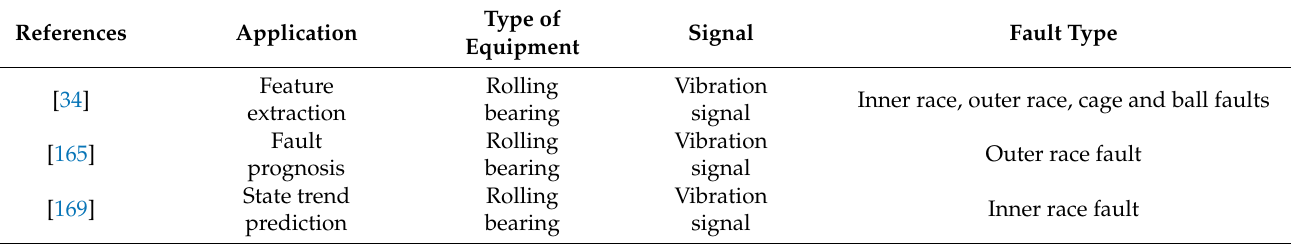
Table 23. Bearing condition monitoring using recurrent neural